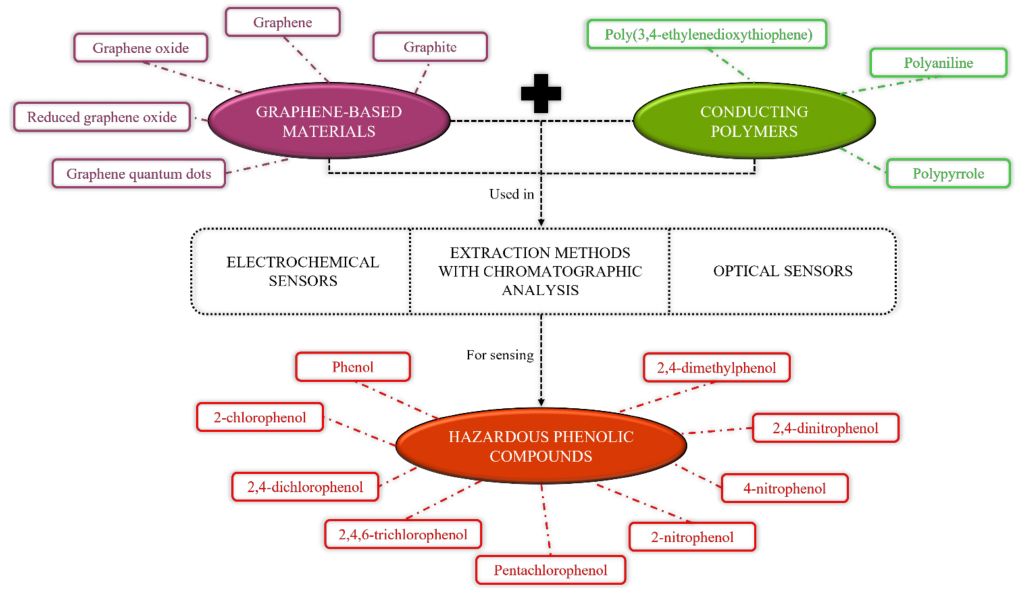
Figure 1. Schematic preparation of the materials and sensing methods discussed in this